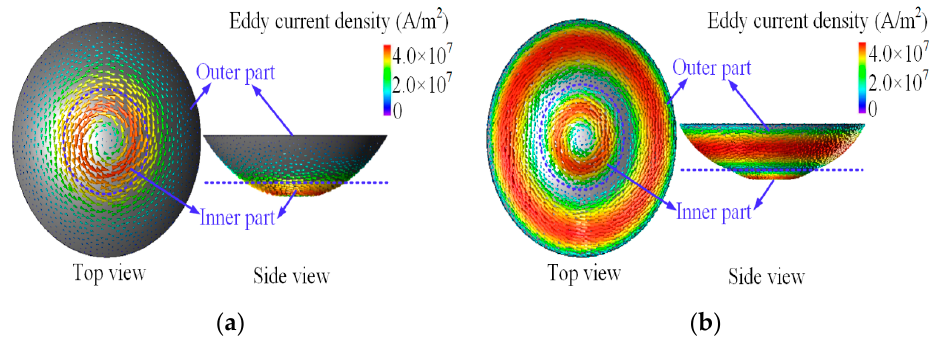
Figure 9. Eddy current density distributions in the wok. ( a ) Without frustum coil. ( b ) With frustum coil.